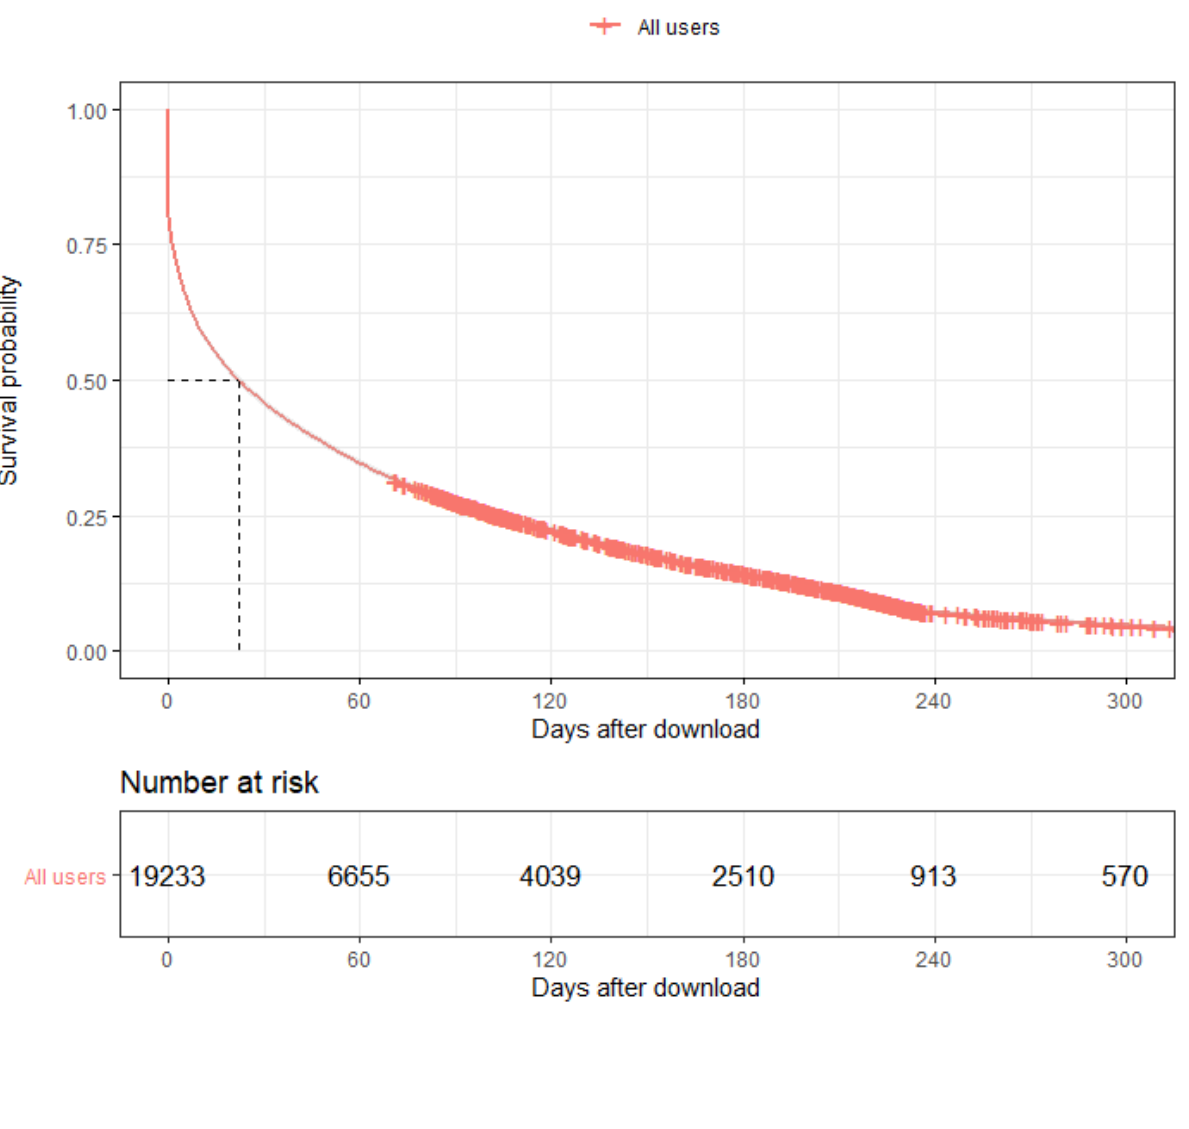
Figure 5. Time to disengagement (defined as the first day of 7 or more consecutive days of no use) for all